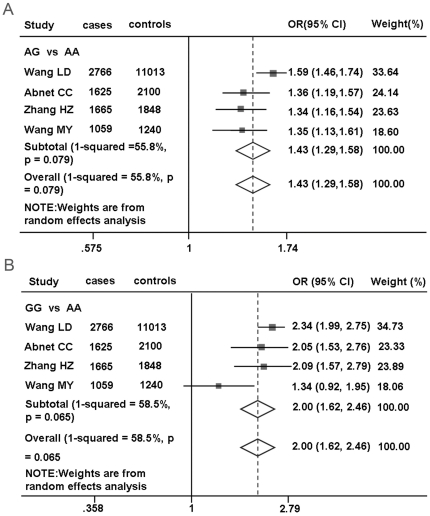
Forest plot showing associations between PLCE1 rs2274223 and gastric cancer risk.A) The ORs and 95% CIs were obtained using AG vs. AA. B) The ORs and 95% CIs were obtained using GG vs. AA. The axis corresponds to the OR. The diamonds and the horizontal bars represent the overall ORs with 95% CIs given by their width.